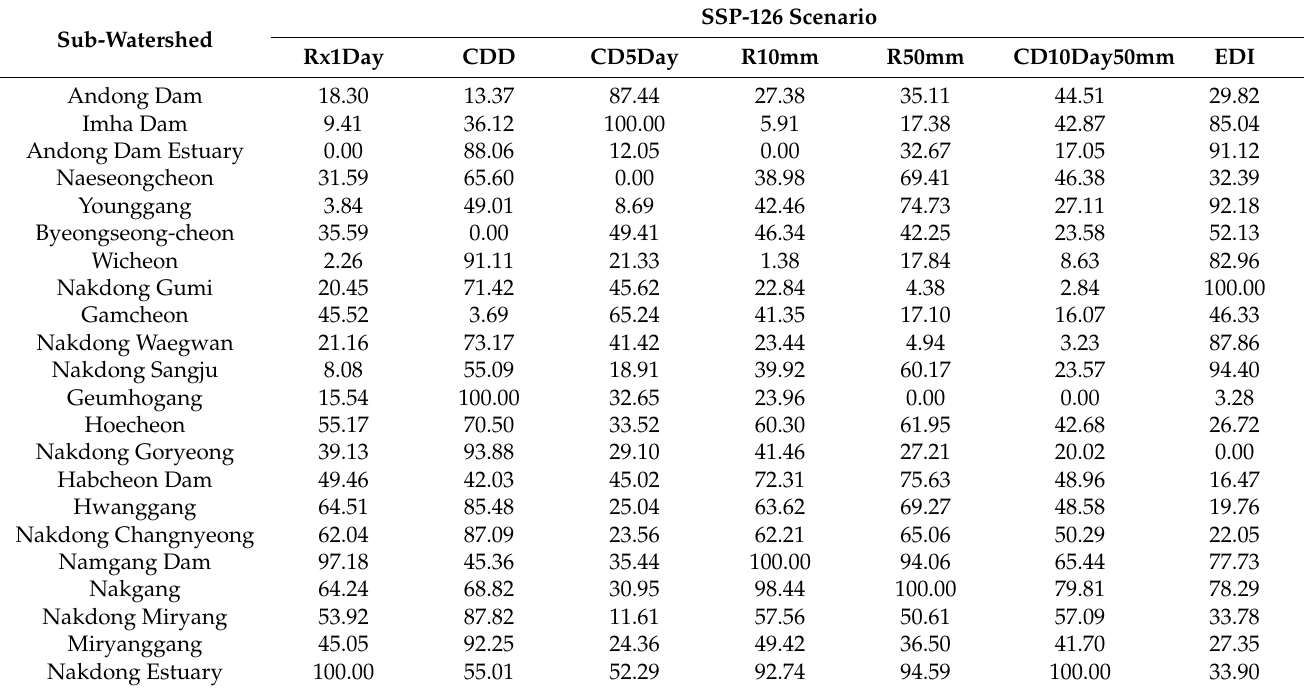
Table 5. Standardized indices of climate change exposure in scenario SSP-126.